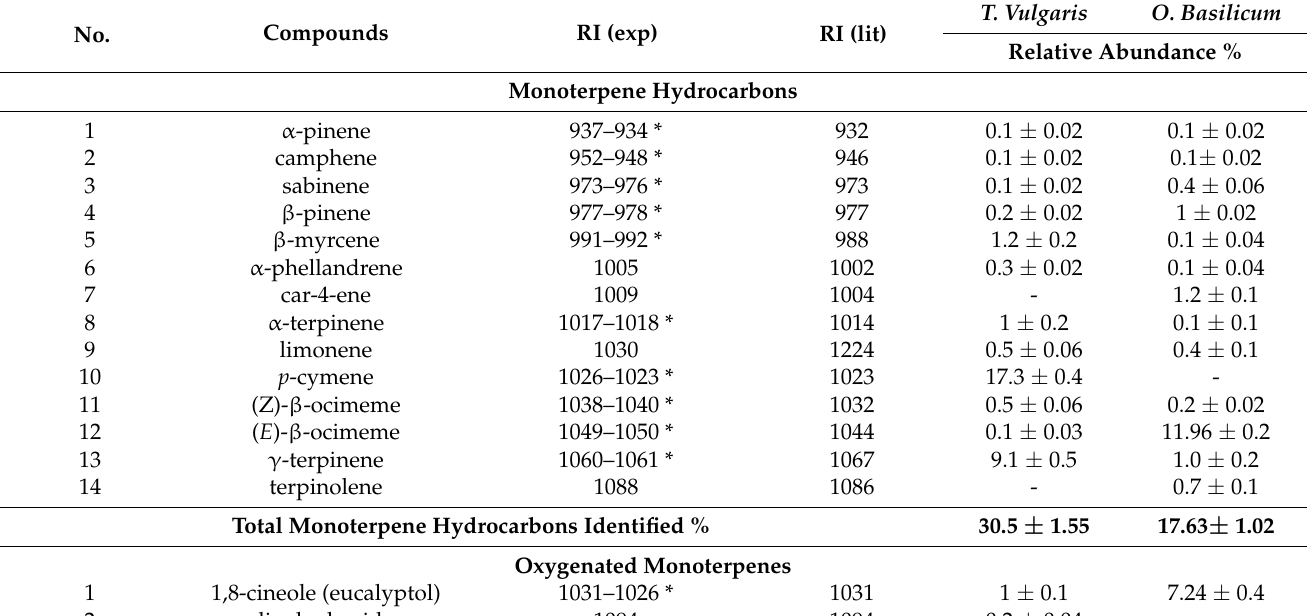
Table 2. Chemical composition of monoterpene hydrocarbons, oxygenated monoterpenes, sesquiterpene hydrocarbons, oxygenated sesquiterpenes, total phenylpropanoids, classes, and the total identified extract from the cell suspensions of T. vulgaris and O.